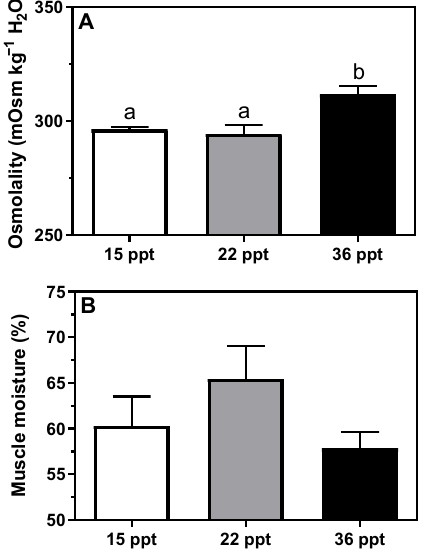
Figure 1. Changes in ( A ) plasma osmolality and ( B ) muscle water content in S. dumerili individuals acclimated to different environmental salinities (15, 22, and 36 psu). Data are presented as mean ±SEM (n= 10–11). Different superscript letters indicate significant differences among salinities ( p < 0.05, one-way ANOVA followed by Tukey´s post hoc test).